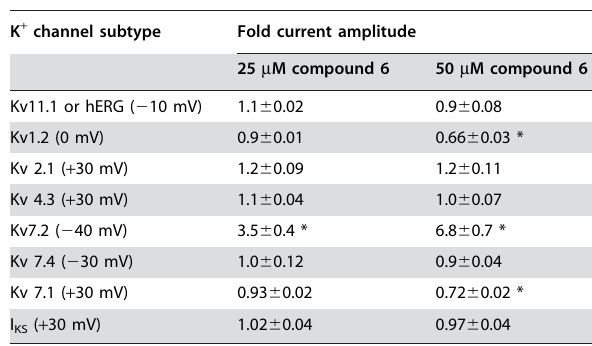
Table 2. Specificity of compound 6 on different K +